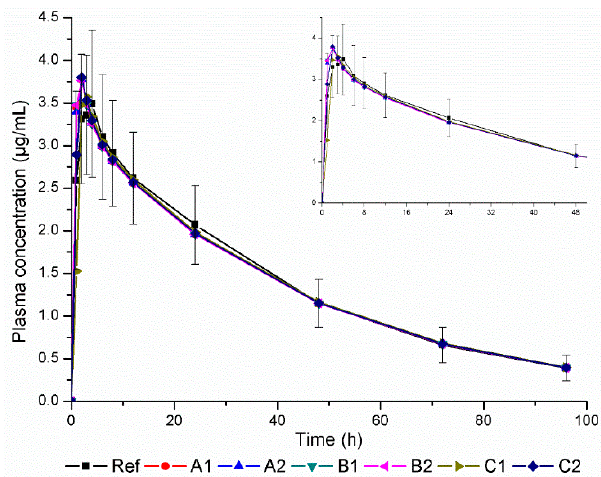
Figure 2. Plasma concentration-time curve of reference product (Ref) based on experimental values and of products A1, A2, B1, B2, C1, and C2 created using simulated values given by GastroPlus ™ ; error bars represent the standard deviation for the reference plot. A zoom in of the time period 0–48 h is highlighted for better visualization.